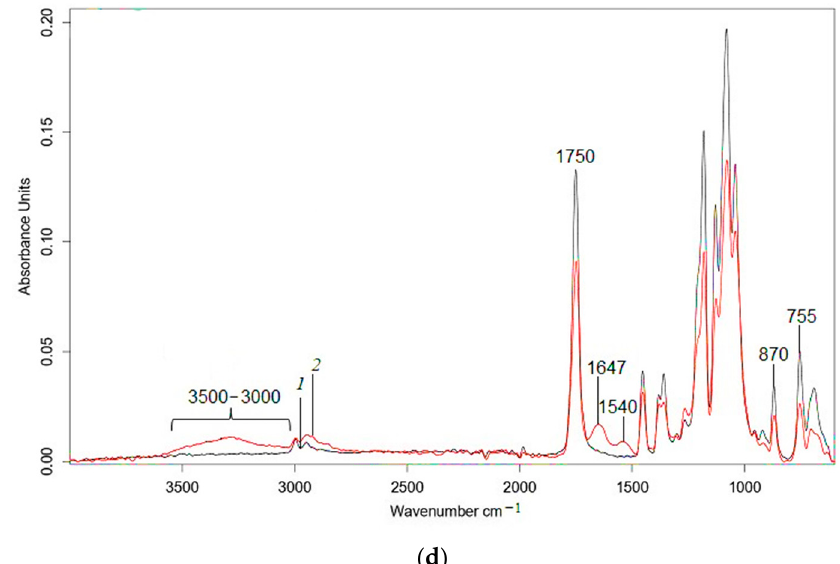
Figure 6. FTIR-ATR spectra of PLA/NR films. The content of NR, wt.%: ( a ) 0; ( b ) 5; ( c ) 10; ( d ) 15. Black: initial samples (1); red: after biotic degradation (2).